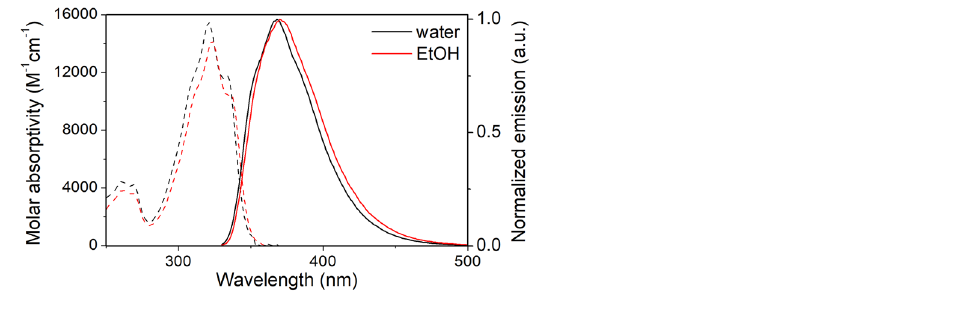
Figure 4. Molar absorptivity (dashed) and normalized fluorescence (solid) spectra of the bT deoxyribonucleoside ( 1 ) in water and